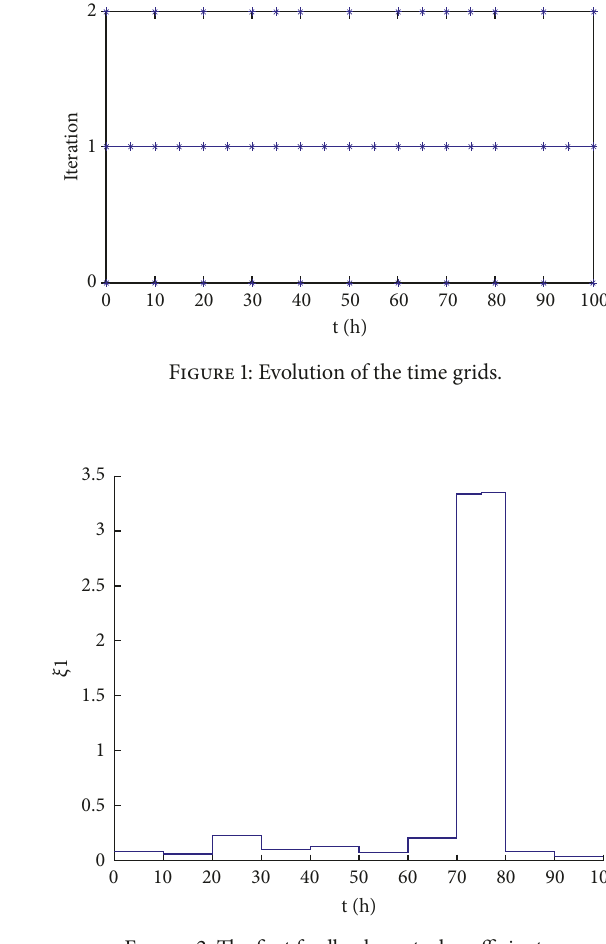
Figure 2: The first feedback control